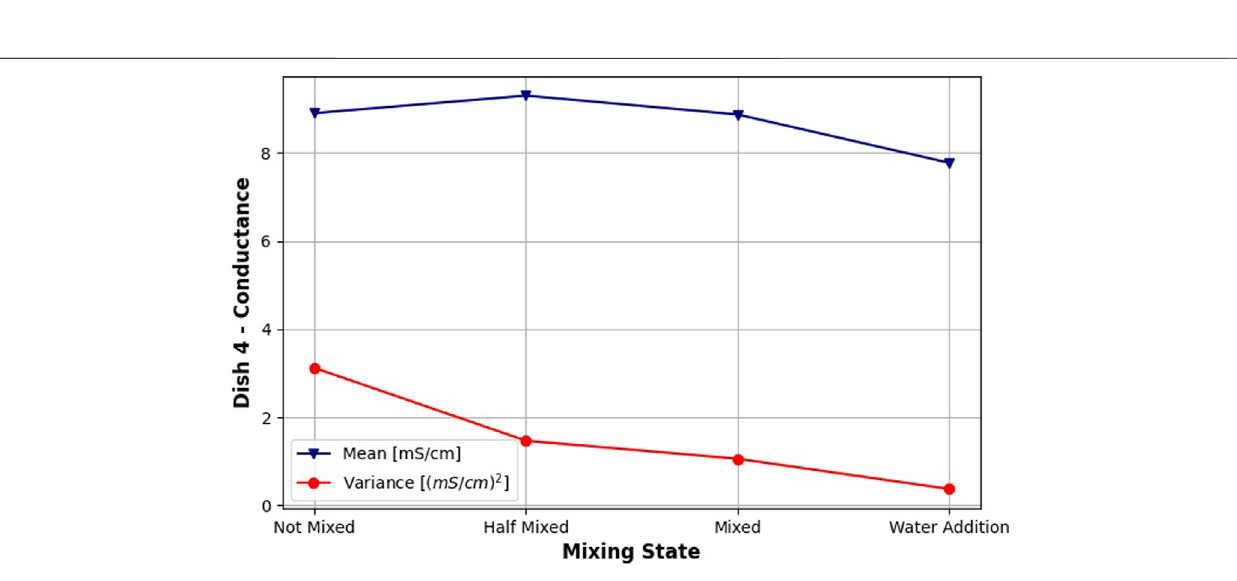
Frontiers in Robotics and AI |